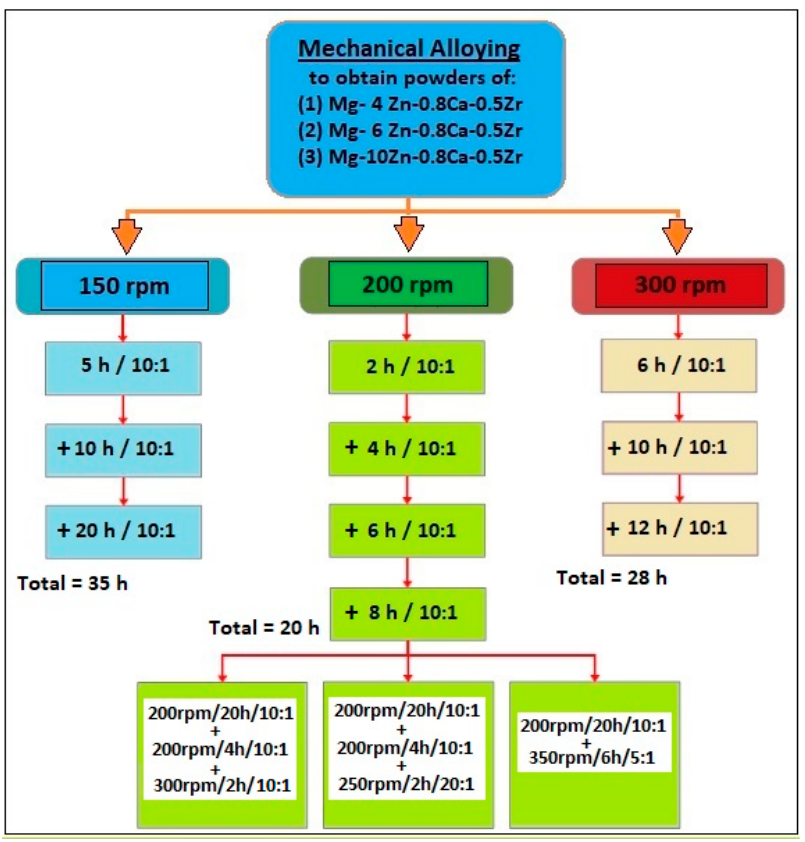
Figure 1. The experimental scheme of mechanical alloying process applied for each of three new compositional variants of studied Mg alloy; various milling speed [rpm]; various milling times [h]; various powder to oxide ball weight ratios.